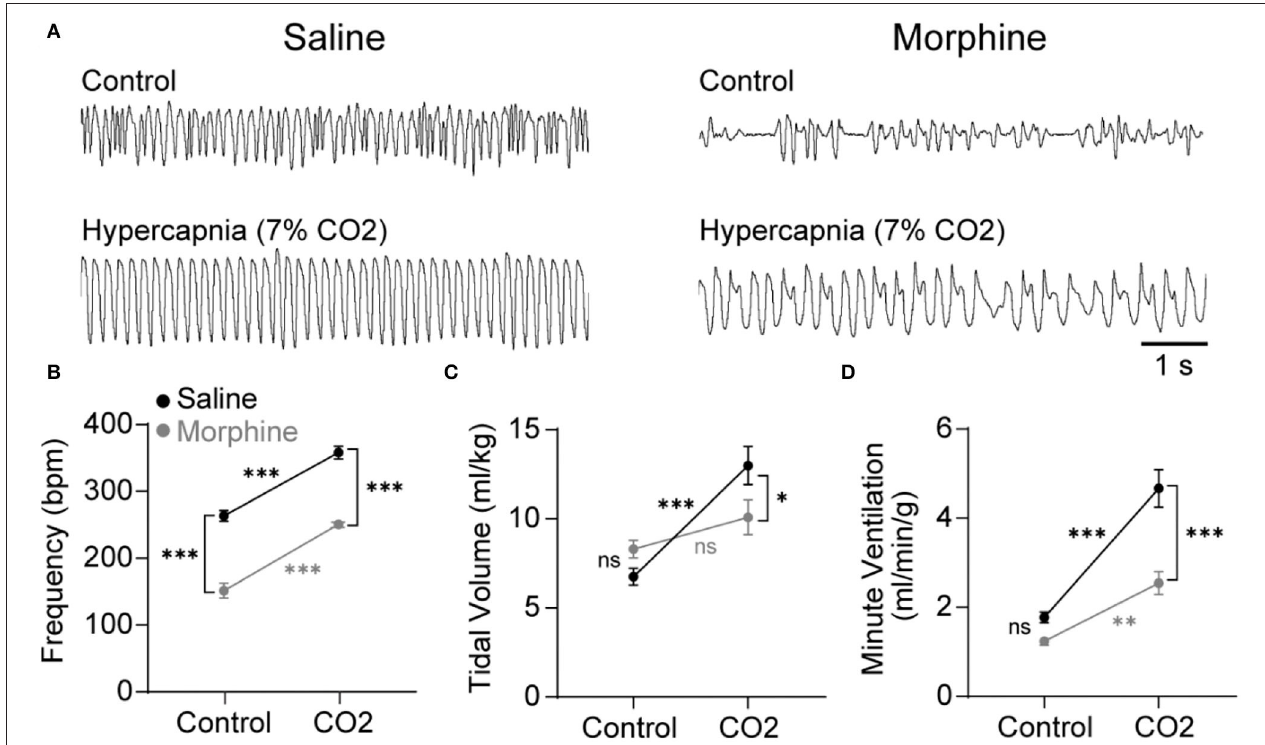
FIGURE 1 | Morphine suppresses breathing during control and hypercapnic conditions in wild-type mice. Respiration was measured during control conditions (standard room air) or hypercapnia challenge (7% CO 2 ) using whole-body plethysmography following an injection of saline (black symbols) or morphine (30 mg/kg; gray symbols). (A) Representative plethysmography traces during each of the four conditions. Scale bar applies to all traces. Inspiration is downward. (B–D) Saline control n = 11, morphine control n = 11, saline hypercapnia n = 10, morphine hypercapnia n = 10. Data are graphed as mean ± SEM. * p < 0.05, *** p < 0.0001,